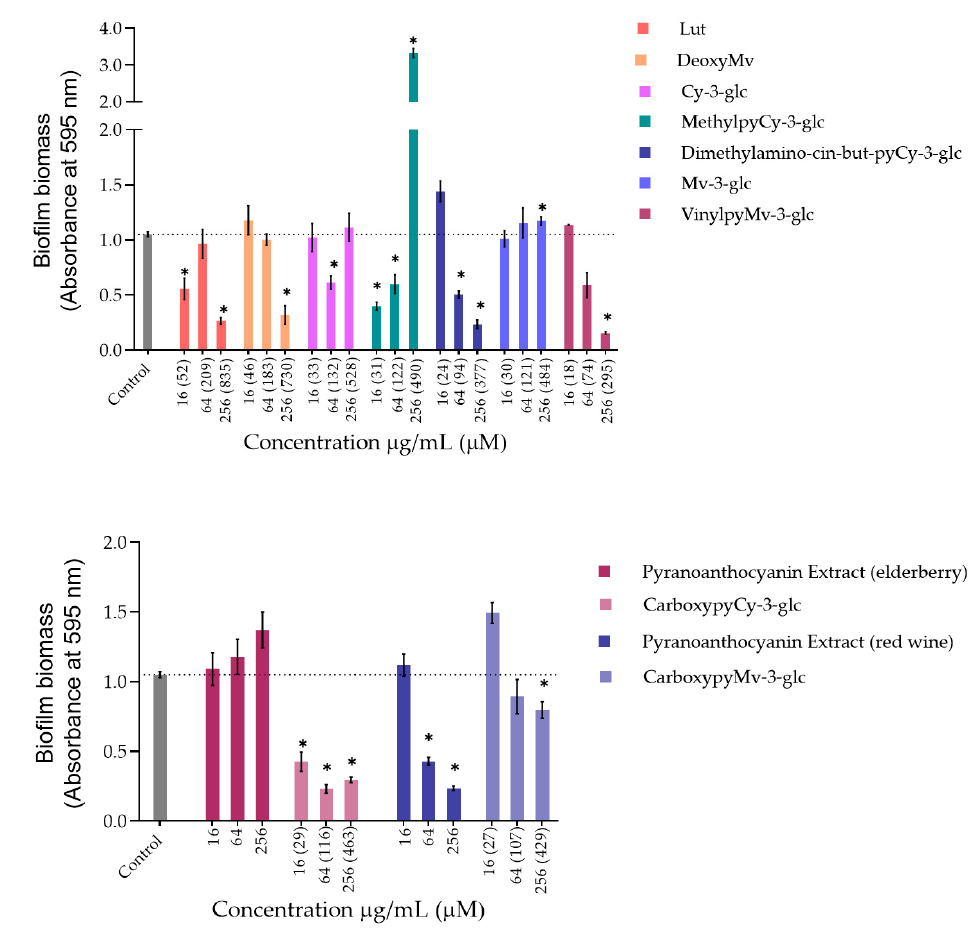
Figure 3. Biomass quantification of biofilms of S. aureus ATCC 29213 formed in the absence (control) and in the presence of different concentrations of extracts and compounds: 256 µ g/mL, 64 µ g/mL and 16 µ g/mL. Statistically significant differences between biofilms formed in presence of ex- tract/compound and control biofilm ( p < 0.05) are marked with an